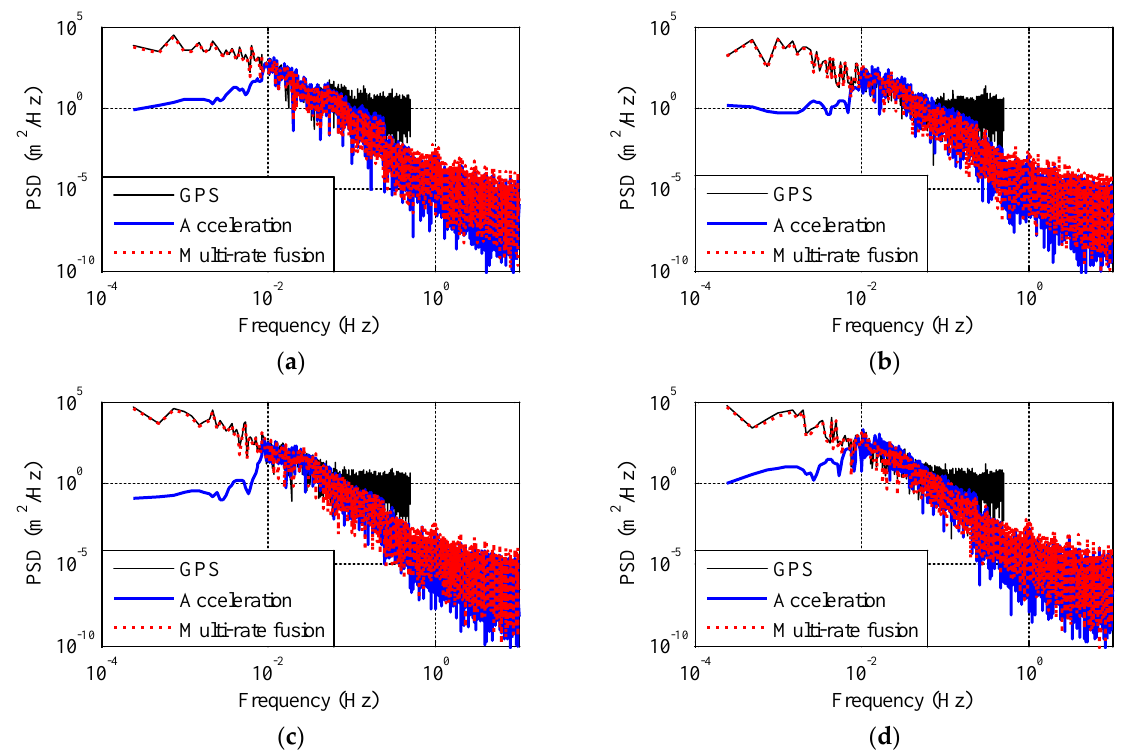
Figure 8. Power spectral density of GPS, ACC, and fused displacement from Cases 1–4. ( a ) Case 1. ( b ) Case 2. ( c ) Case 3. ( d ) Case 4.